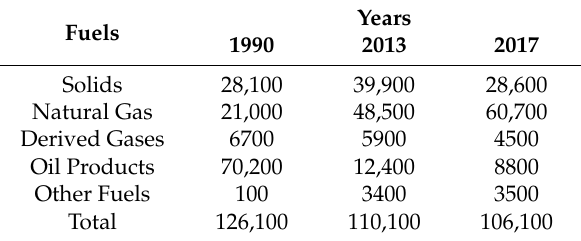
Table 7. Greenhouse gases (GHG) emissions from thermoelectric generation in Italy (Gg CO 2 eq) [27]. Years Fuels 1990